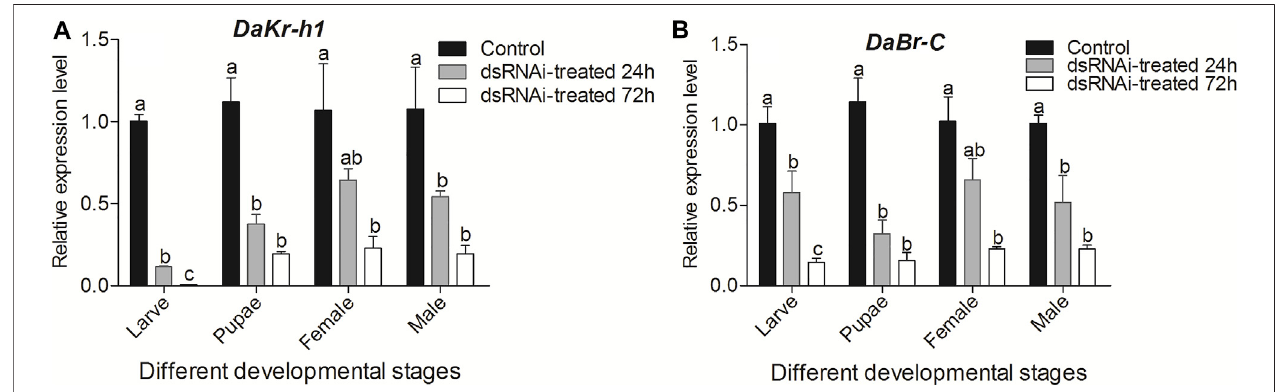
FIGURE7| qRT-PCRanalysisof DaKr-h1 and DaBr-C transcriptpatterns in D.armandi afterbeing injected withdsRNA for24and72 h. (A) DaKr-h1 ; (B) DaBr-C . Error bars indicate standard error of the mean of three biological replicates (One-way ANOVA, p < 0.05, with Tukey ’ s test of multiple comparisons).